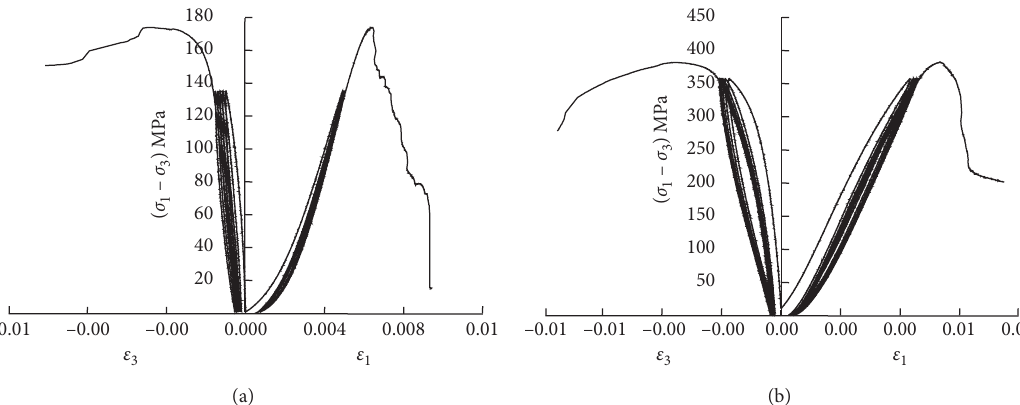
Figure 3: Stress-strain curves of triaxial cyclic loading and unloading tests with varying confining pressures. (a) The confining pressure is 0MPa. (b) The confining pressure is 30 confining pressure in general, which is the same as the are plotted according to the data in Tables 5 and 6 relationship between peak strength and confining pressure (Figure 5(b)). Under cyclic loading and unloading, the under conventional triaxial conditions. The elastic modulus peak strength of specimens increases with increasing con- increases first and then decreases with confining pressure. fining pressure (Figure 5). Peak strength is linearly related to